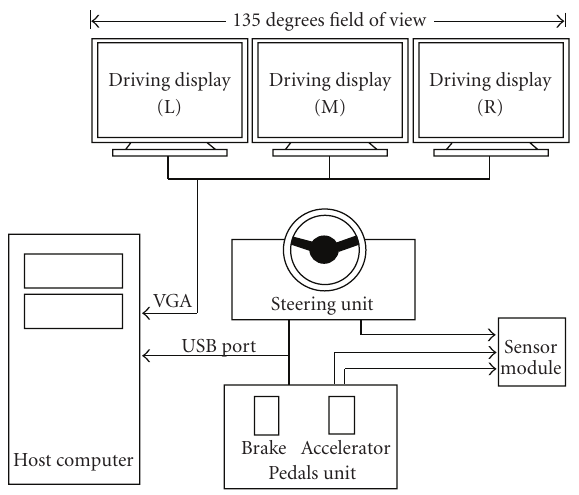
Figure 3: Diagram of the simulated driving